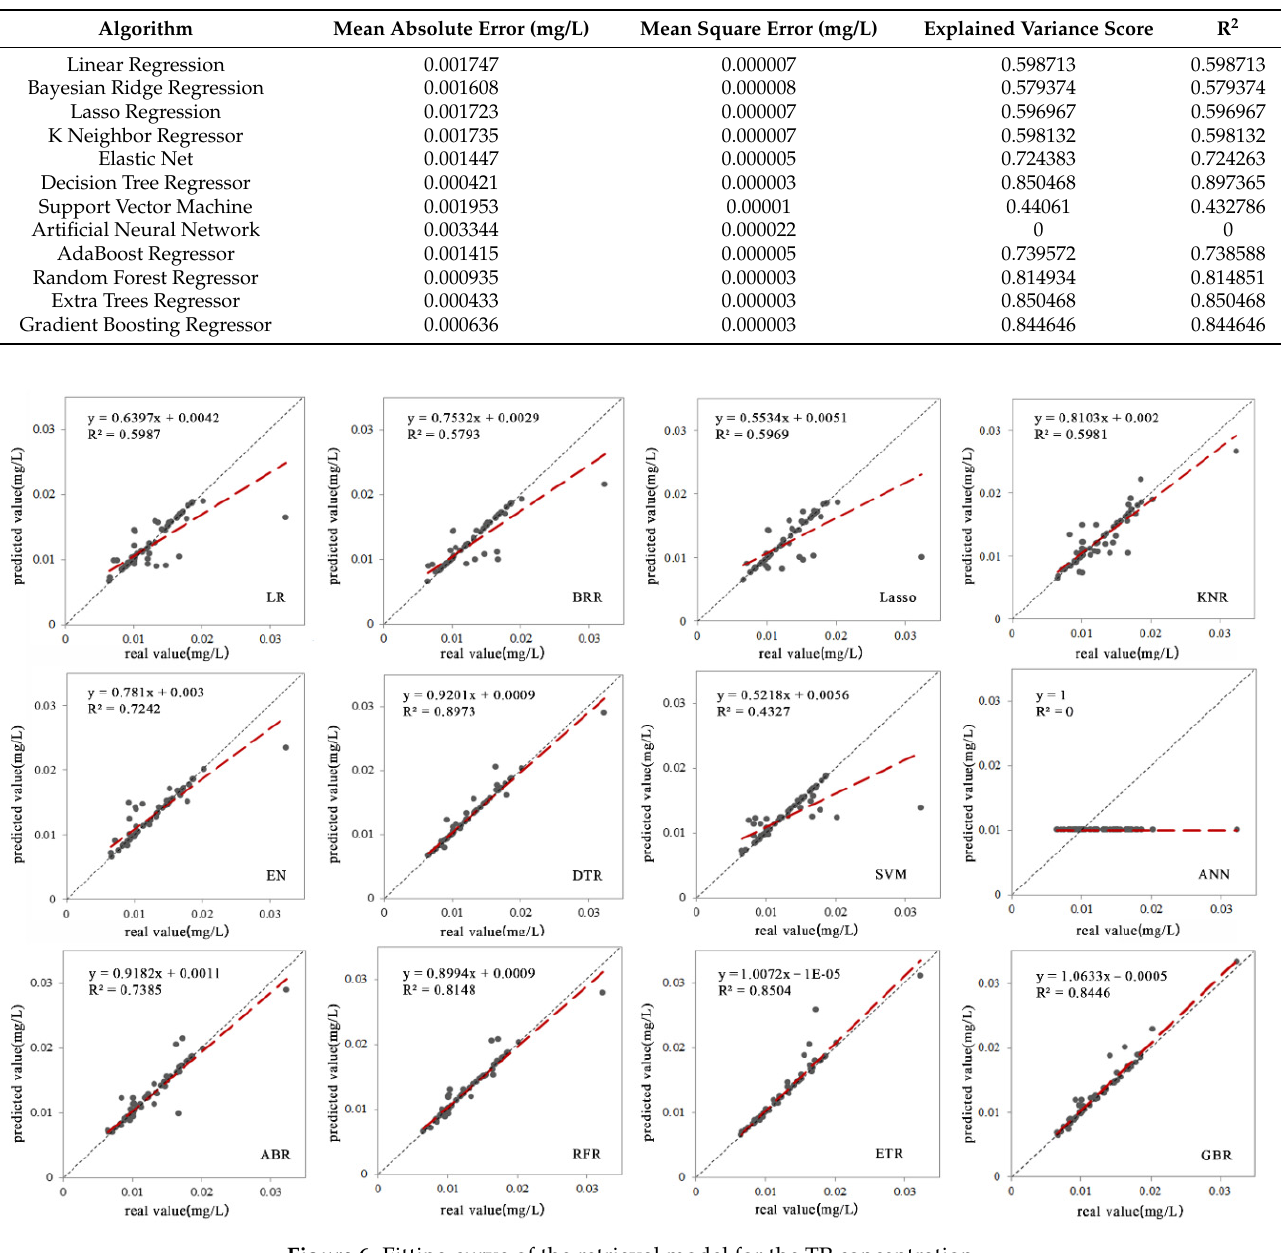
Figure 6. Fitting curve of the retrieval model for the TP concentration. As seen from the assessment parameters of model performance, the two best-performing algorithms were obtained to be DTR and ETR with the R 2 values higher than 0.85, the MAE lower than 0.000433 mg/L, and MSE lower than 0.000003 mg/L. Then it was followed by the GBR and RFR with the R 2 of 0.844646 and 0.814851, respectively (Table 1). It meant that the fits were representative of the ground monitoring data by 84.5% and 81.5%,